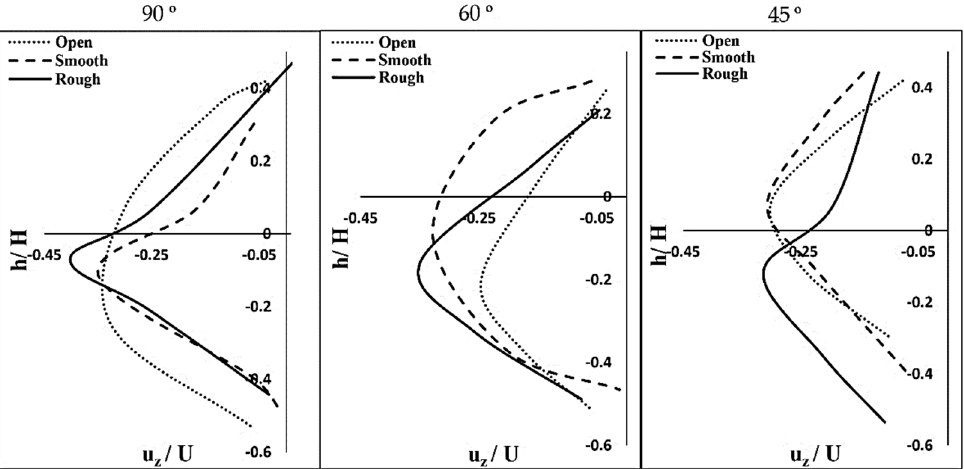
Figure 15. Vertical velocity profile (u z ) inside and outside the scour holes under conditions of different surface covers and different dike orientation angles (water depth: 21.5 cm). ADV measurements subject to +/- 0.25 cm/s error.